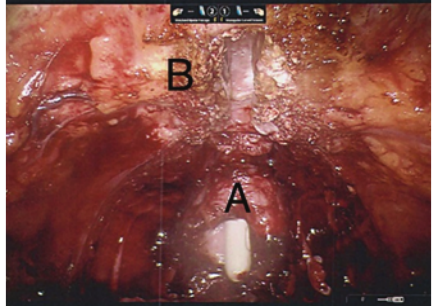
Figure 2: Operative view of prostatosymphyseal fistula. Following division of communication between the prostate and symphysis pubis, a large defect in the anterior prostate (A) is seen, exposing the urethral catheter. The symphysis pubis cartilage has been completely excavated